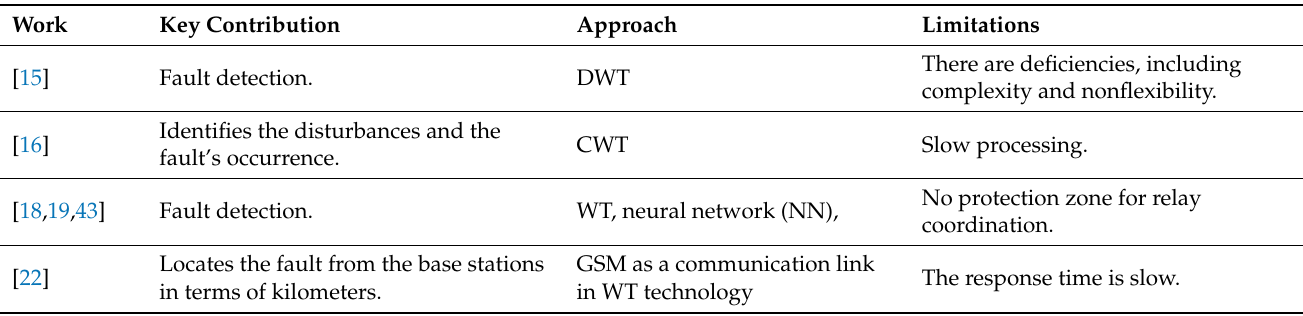
Table 1. Comparative analysis of wavelet-transform methods for fault